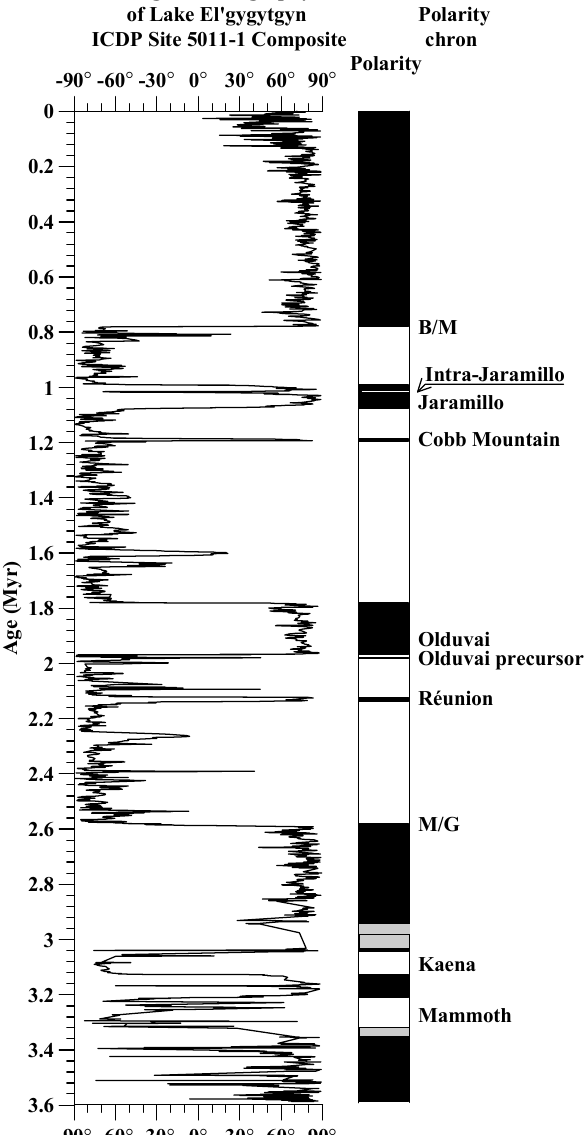
Fig. 13. Composite record of ChRM inclinations from ICDP Site 5011-1 in Lake El’gygytgyn. In the polarity column, black (white) [grey] denotes normal (reversed) [missing] polarity. Onset of the Mammoth subchron and termination of Kaena are some- what ambiguous due to missing sediment and low data quality at these depths in the composite. Their reliability as tie points is not